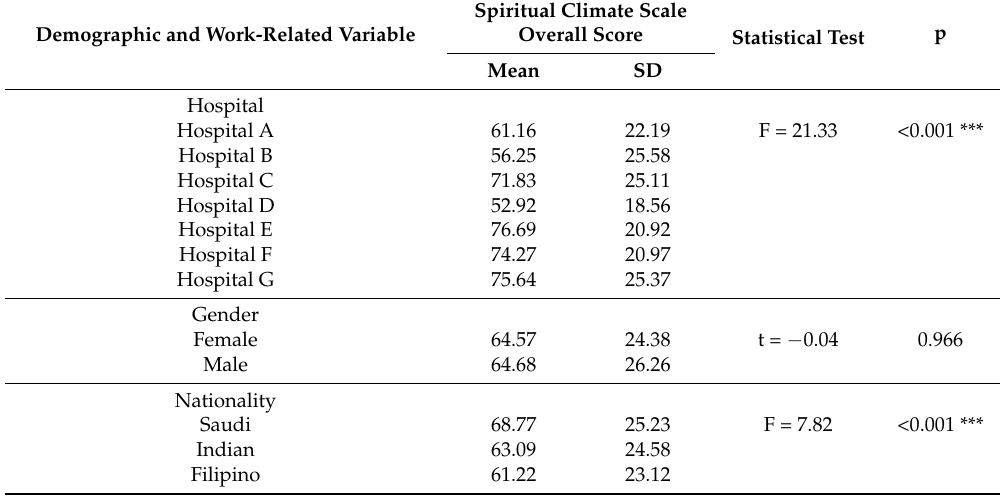
Table 3. The association between demographic and work-related variables and the spiritual climate perceptions among nurses (n =